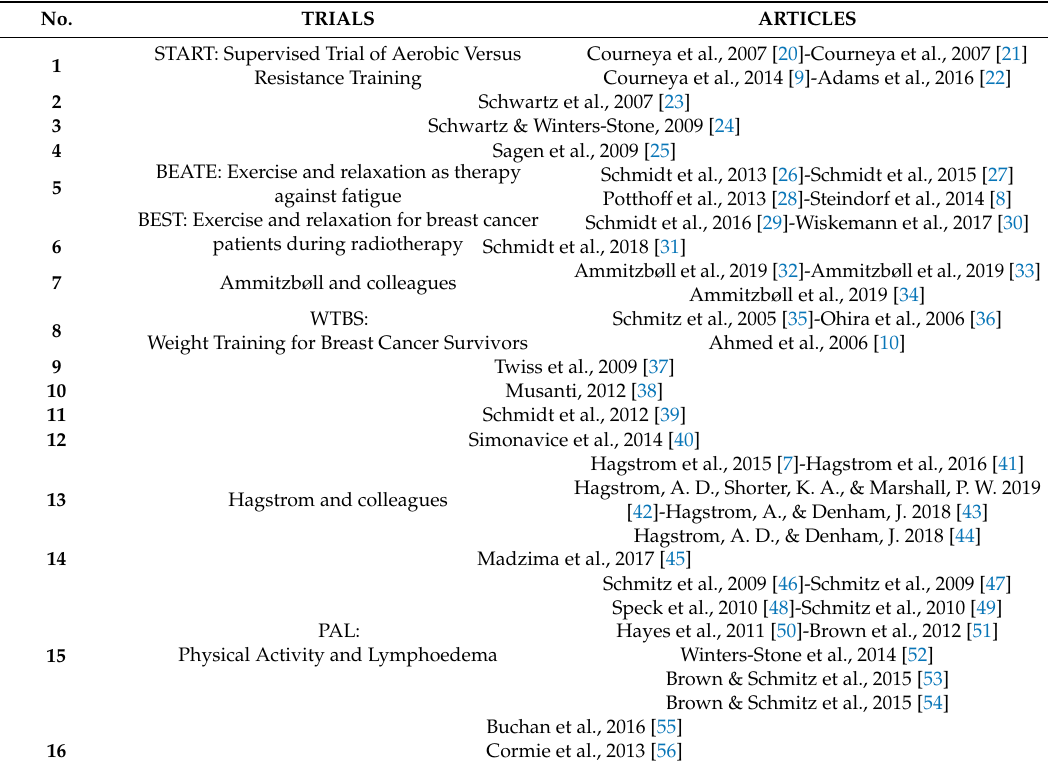
Figure 1. Flow chart for systematic review methodology as per Preferred Reporting Items for Systematic Reviews and Meta-Analyses (PRISMA) guidelines. RT = resistance training; RCT = randomized controlled trial. Table 4. Studies included in the review.